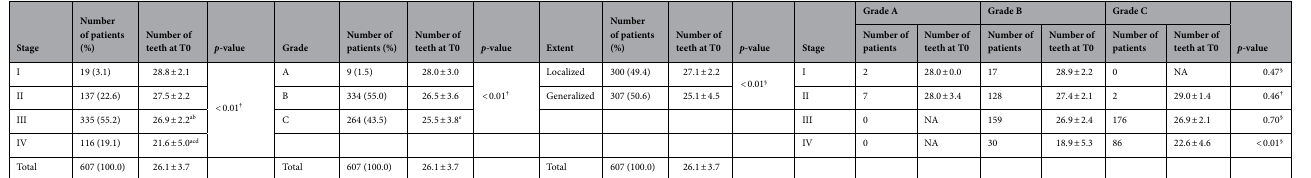
the respective stages and grades according to the new 2018 classification (Table 3 and Supplemental Table 2). The Kruskal–Wallis test detected significant differences between the groups. Patients in stage I, stage II, and grade A had no TLPD during the total treatment period. Patients in stage IV, grade C had TLPD rates of 0.24 ± 0.31, 0.15 ± 0.24 (number of teeth/patient/year), respectively, with significant differences when compared with those in the other stages and grades. During both APT and SPT, similar to TLPD rates for respective stages and grades